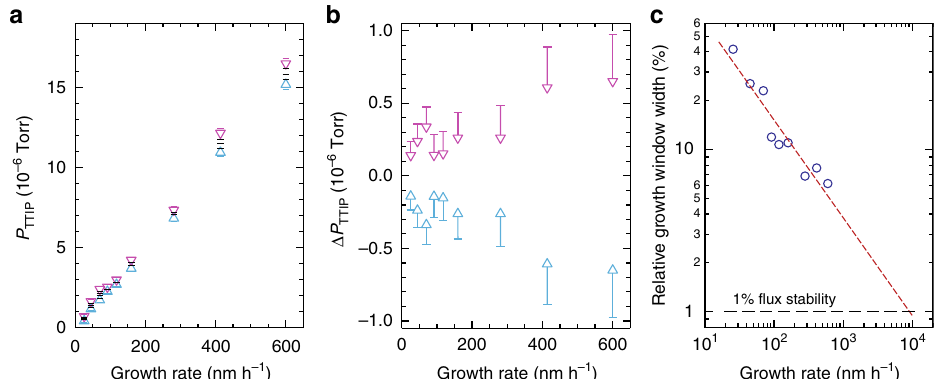
Fig. 3 Scaling growth window. a Titanium tetraisopropoxide (TTIP) beam equivalent pressures p TTIP as a function of fi lm growth rate for which a growth window was accessed. The Sr fl ux was kept fi xed while the TTIP fl ux was modulated. The black bars represent p TTIP values within the growth window, while the upper red and lower blue triangle indicate the edges of the growth window determined by re fl ection high-energy electron diffraction (RHEED). The red and blue bar above and below the respective triangles are the fi rst p TTIP values for Ti-rich and Sr-rich growth conditions, respectively. b Absolute growth window width Δ p TTIP as a function of growth rate. The triangles mark the edges of the growth window, while the bars are the values at which a nonstoichiometric growth front was observed in RHEED. c Relative growth window width Δ p TTIP / p TTIP as a function of growth rate, where p TTIP is the TTIP beam equivalent pressures at the growth window center. The line is extrapolated based on the existing data set, projecting that a growth rate